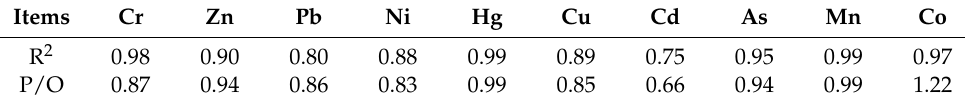
Table 4. The R 2 and P/O values obtained from PMF model in this study.